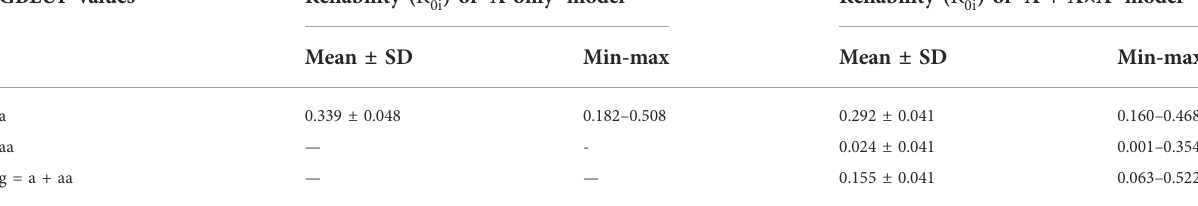
TABLE 3 Reliability estimates of validation cows for the A-only and A + A×A prediction models from 10 validation populations.